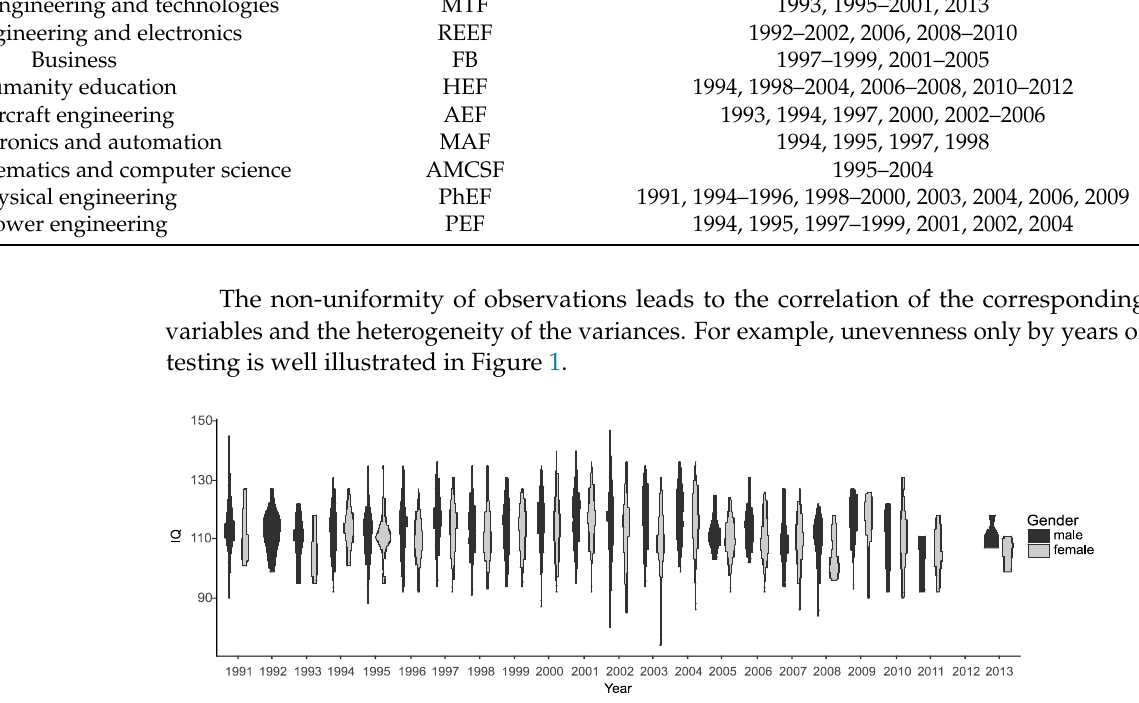
Table 1. Natural distribution of tested students by departments and years.